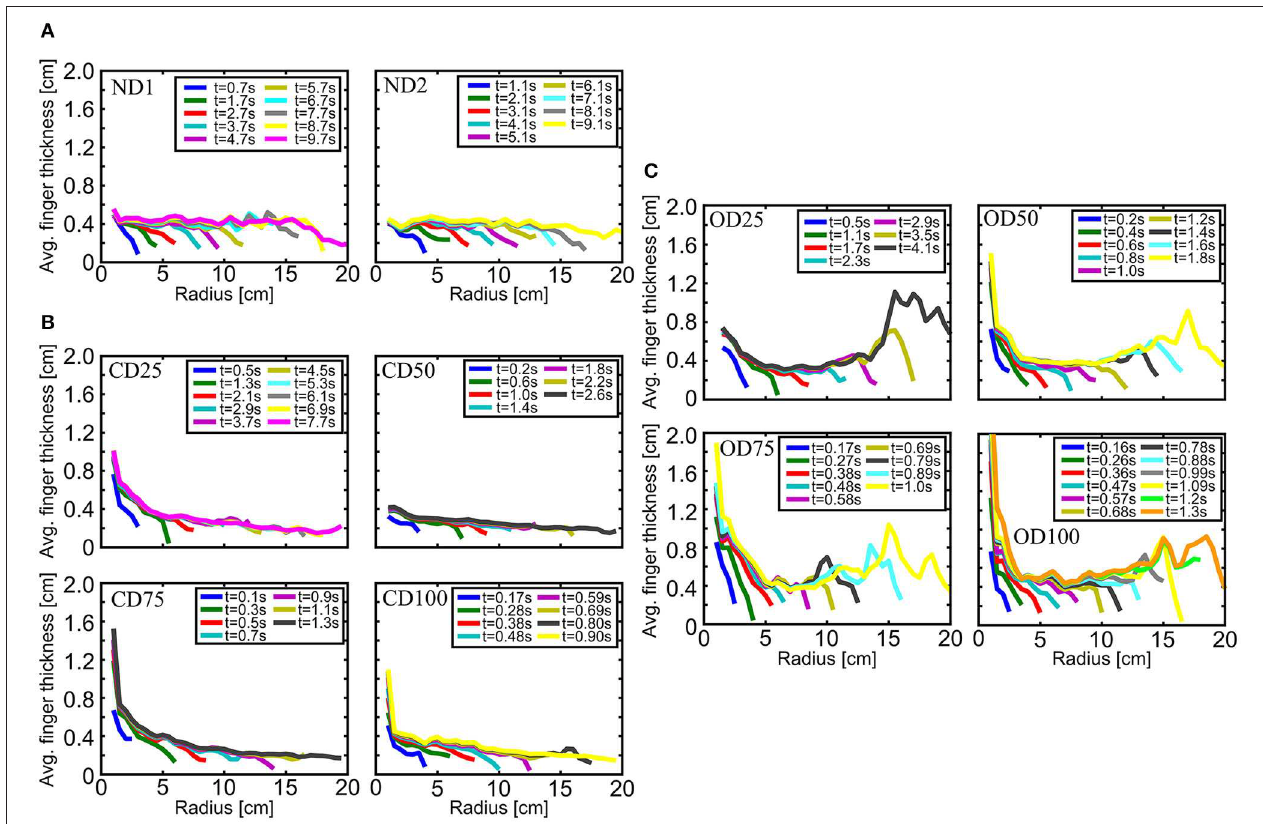
FIGURE 6 | Average finger thickness as function of radius plotted at several snapshots for the non-deformable experiments (A), confined deformable experiments (B), and open deformable experiments (C). The injection pressure in both ND experiments is 25 hPa, while the number in the experiment names for the CD and OD experiments gives the injection pressure in